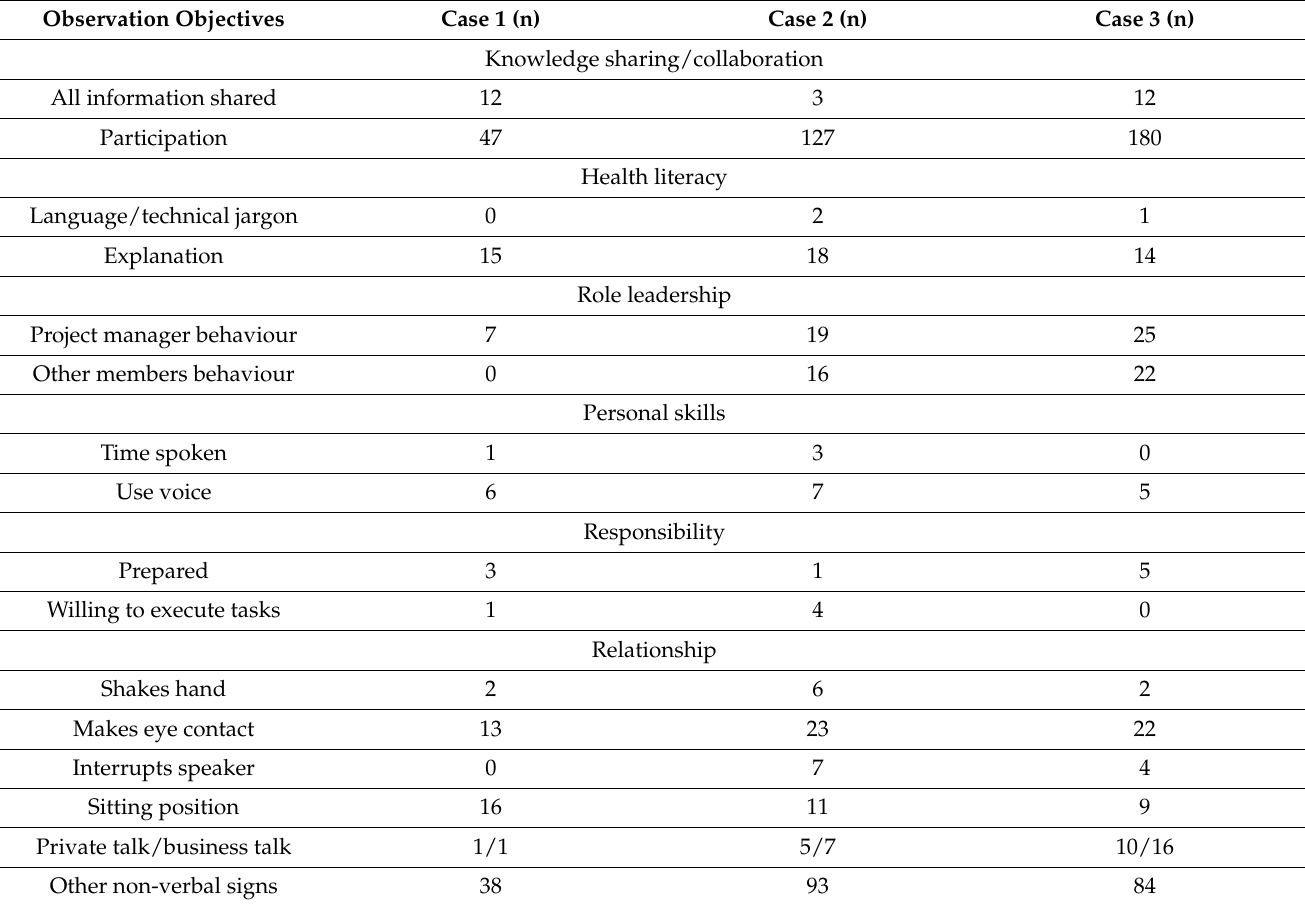
Table 2. Observation objectives; numbers indicate the frequency of observed item.